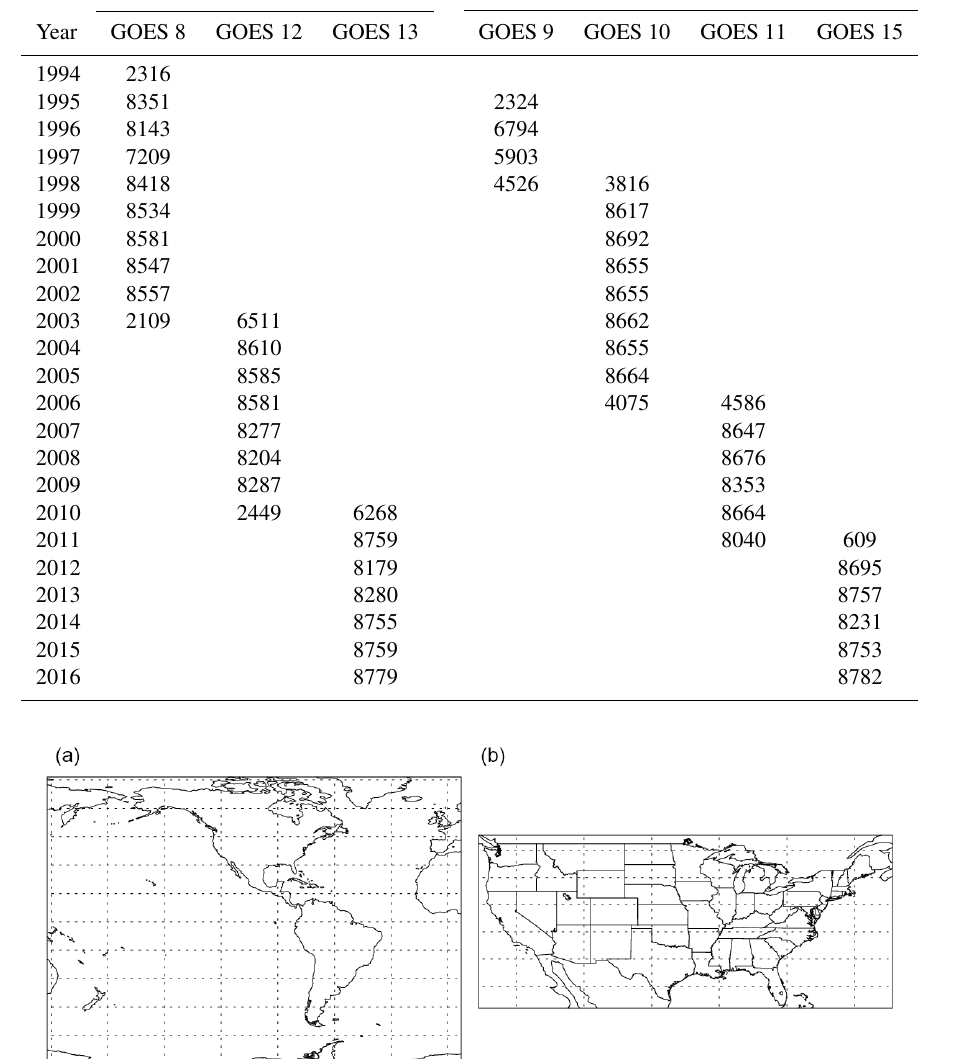
Figure 3. Spatial coverages of the 5375 × 3750 pixel domain of GridSat-GOES (a) and the 1500 × 650 pixel domain of GridSat-CONUS (b)